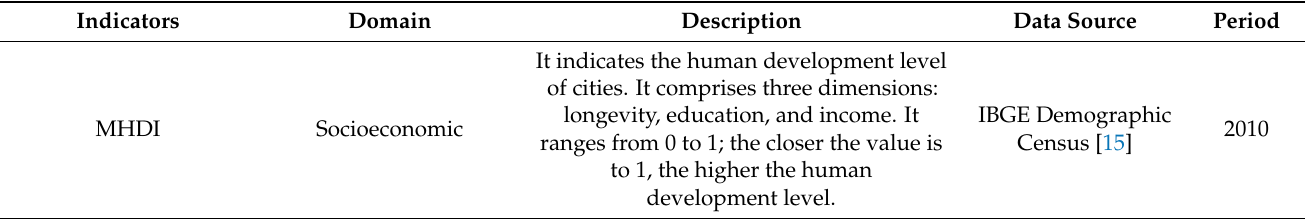
Table 1. Contextual (socioeconomic, structural, and epidemiological) indicators and data sources.